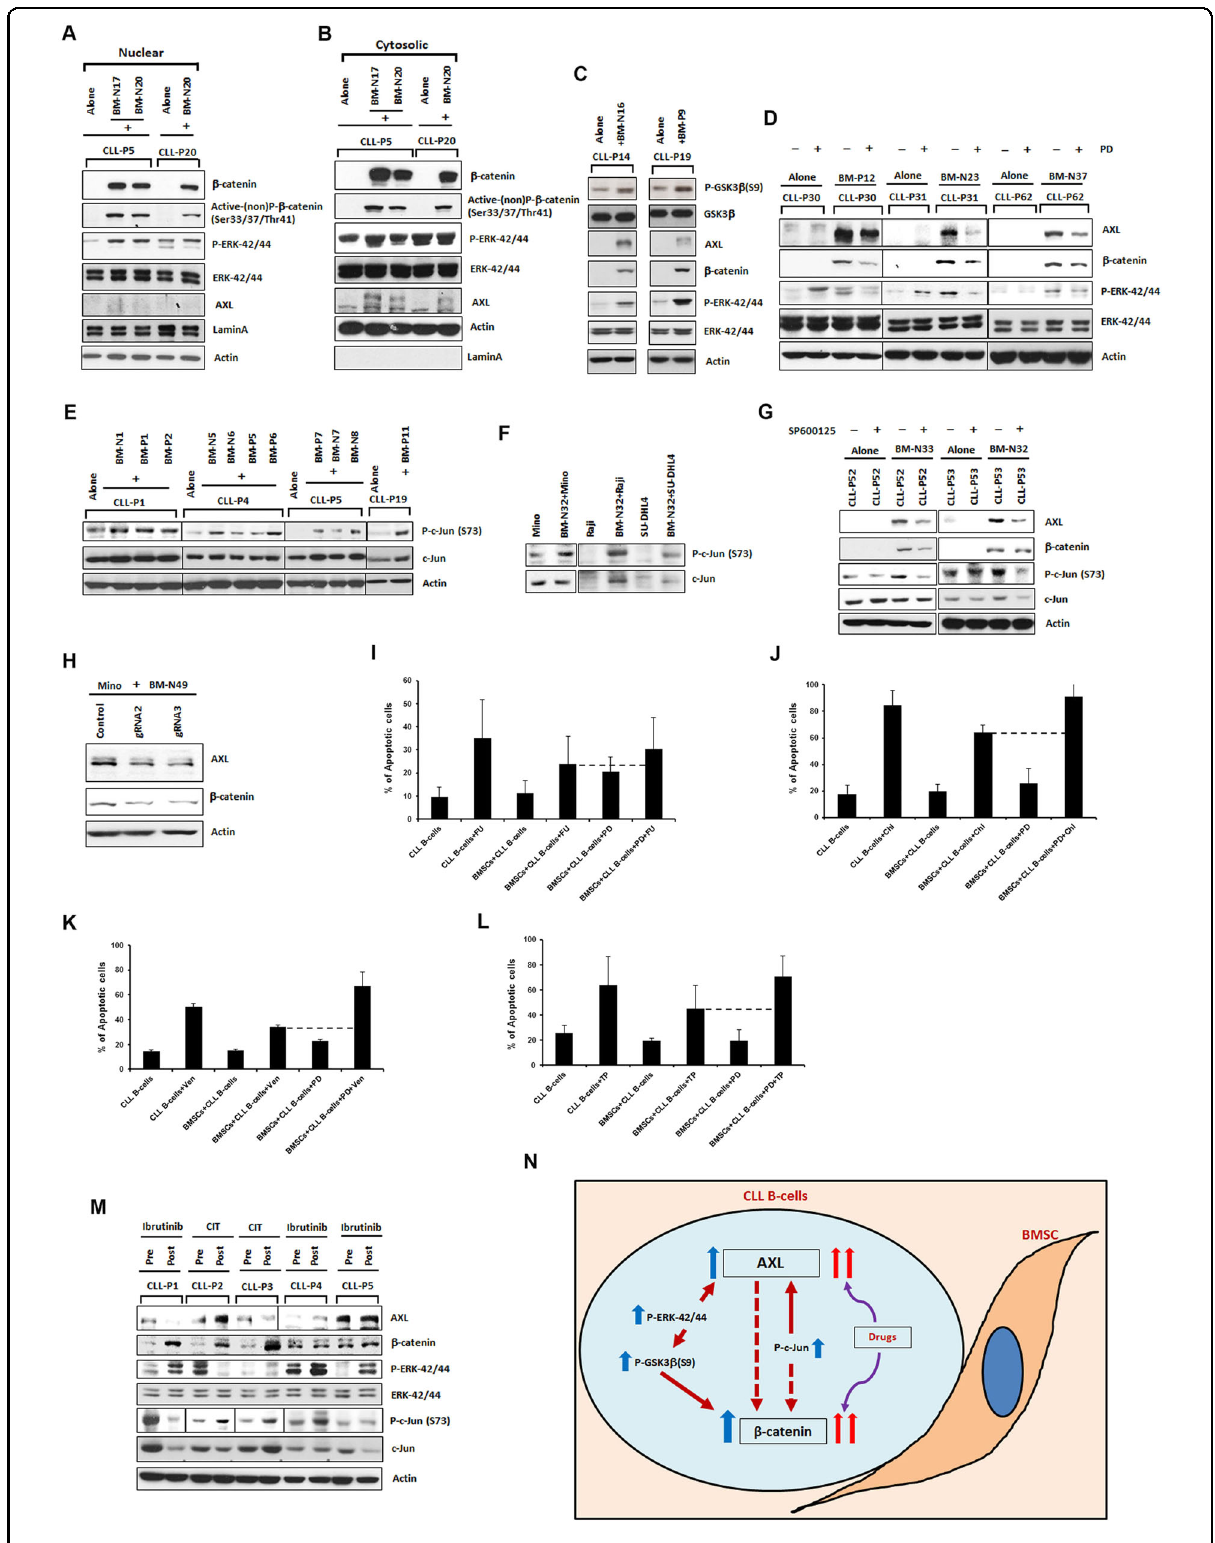
Fig. 2 (See legend on next